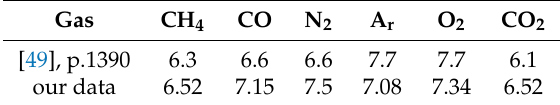
Table 1. The maximum number of binding sites in 10 18 molecules/m 2